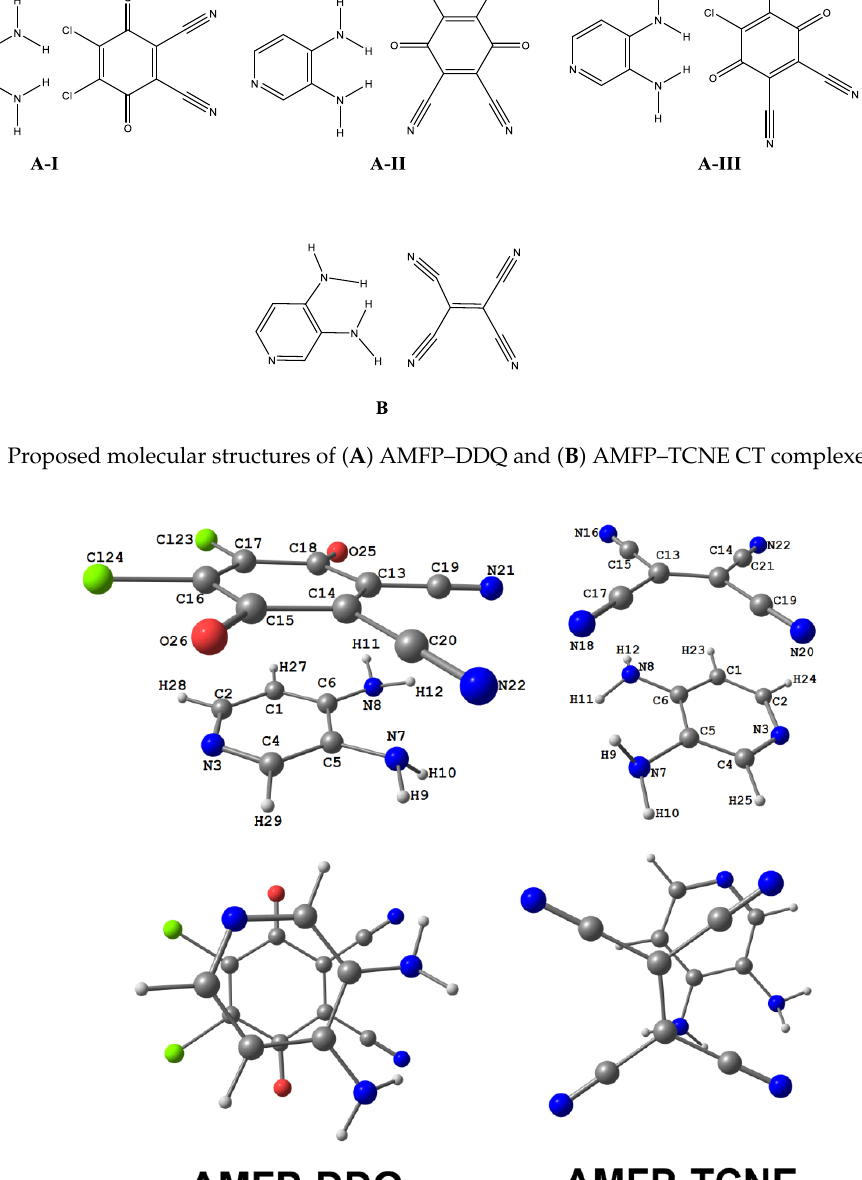
acceptor ( lower ) at the optimized molecular structures of the AMFP–DDQ and AMFP–TCNE CT